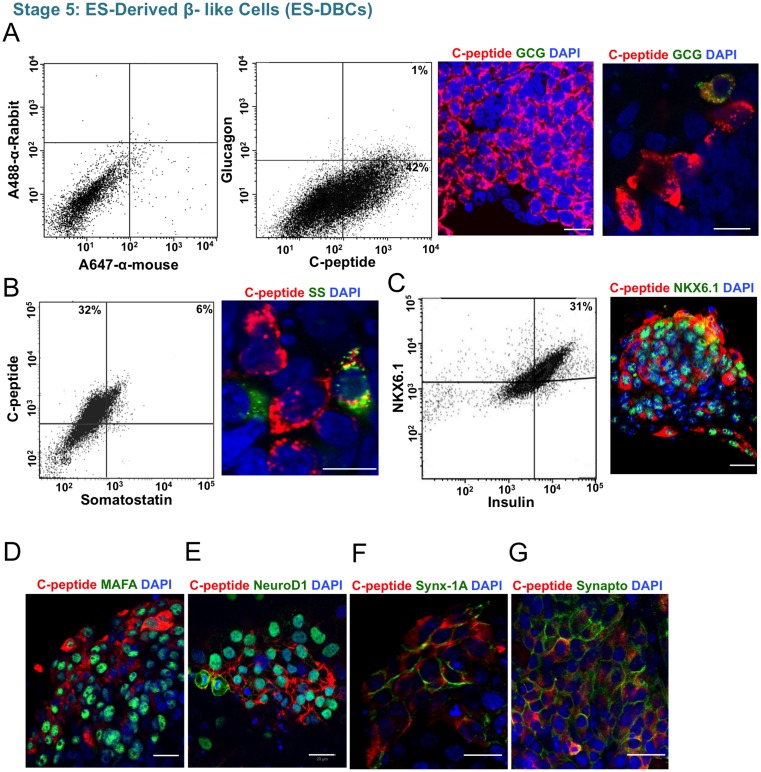
Study of insulin and beta-cell marker expression in the human H1 ES-DBCs at stage 5.(A) Flow cytometry and immunofluorescence staining for C-peptide/Glucagon. From left to right, gating of flow cytometry for detection of C-peptide and glucagon, flow cytometry for C-peptide and glucagon and immunofluorescence staining for C-peptide/glucagon in the ES-DBCs. (B) Flow cytometry and immunofluorescence staining for C-peptide/Somatostatin and (C) Insulin/NKX6.1, in the ES-DBCs. (D) Immunofluorescence staining for C-peptide/MAFA, (E) C-peptide/NeuroD1,(F) C-peptide/Syntaxin-1A, and (G) C-peptide/Synaptophysin in the ES-DBCs at the stage 5. Scale bar = 20μm. GCG: Glucagon, SS: Somatostatin.